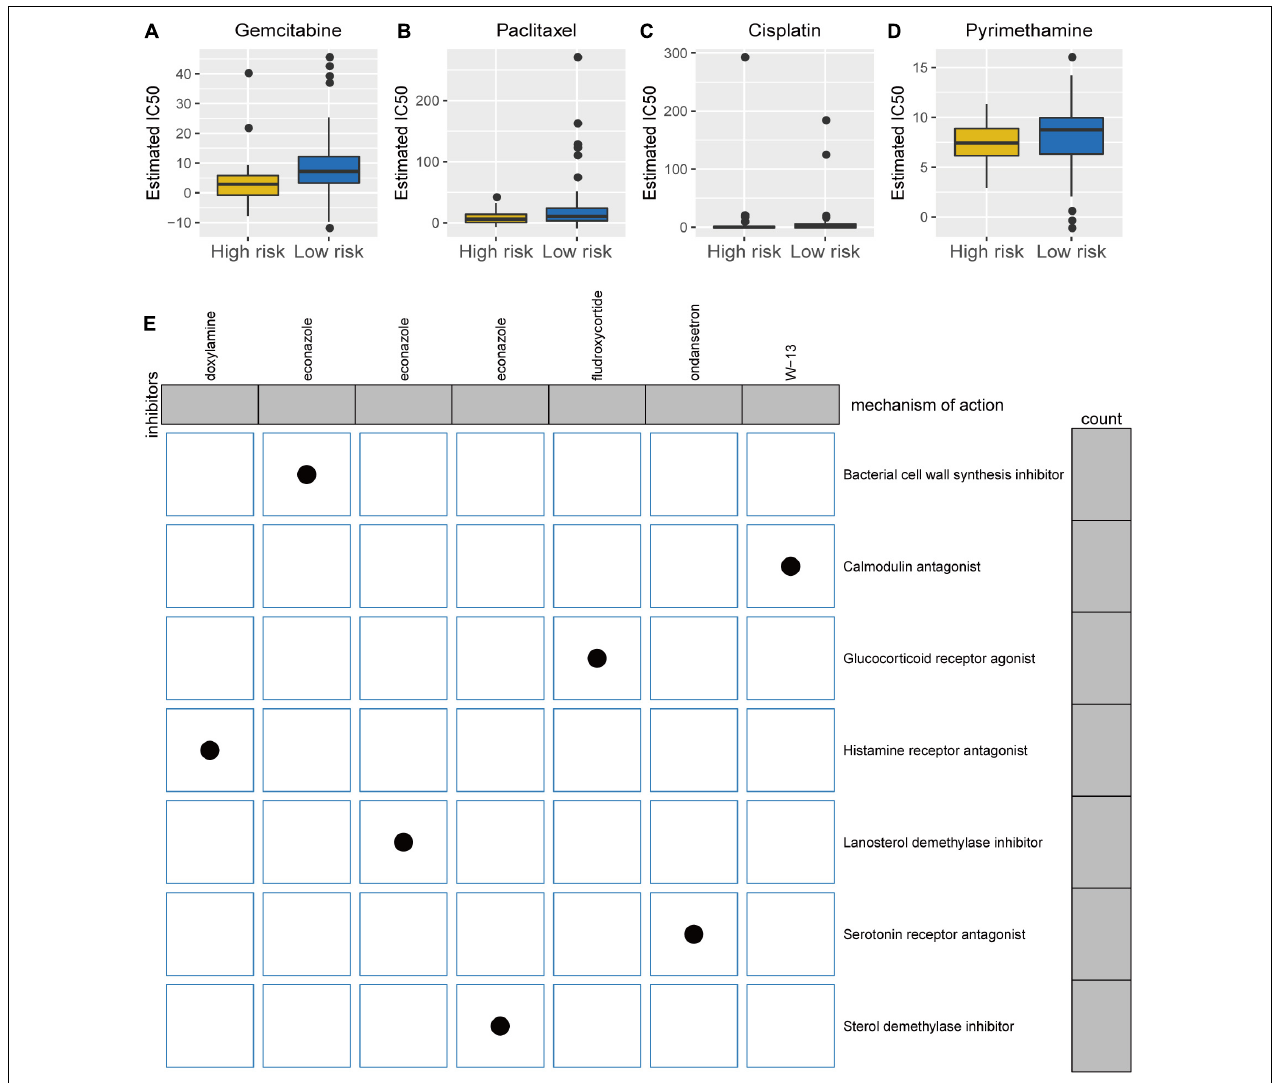
FIGURE 7 | Differential chemotherapeutic responses and targeted traits of patients of high- and low-risk pancreatic cancer (PC). (A–D) Estimated IC 50 for gemcitabine (A) , paclitaxel (B) , cisplatin (C) , and pyrimethamine (D) between high- and low-risk patients with PC. (E) Intrinsic mechanisms of candidate inhibitors targeted the established signature: Connectivity Map